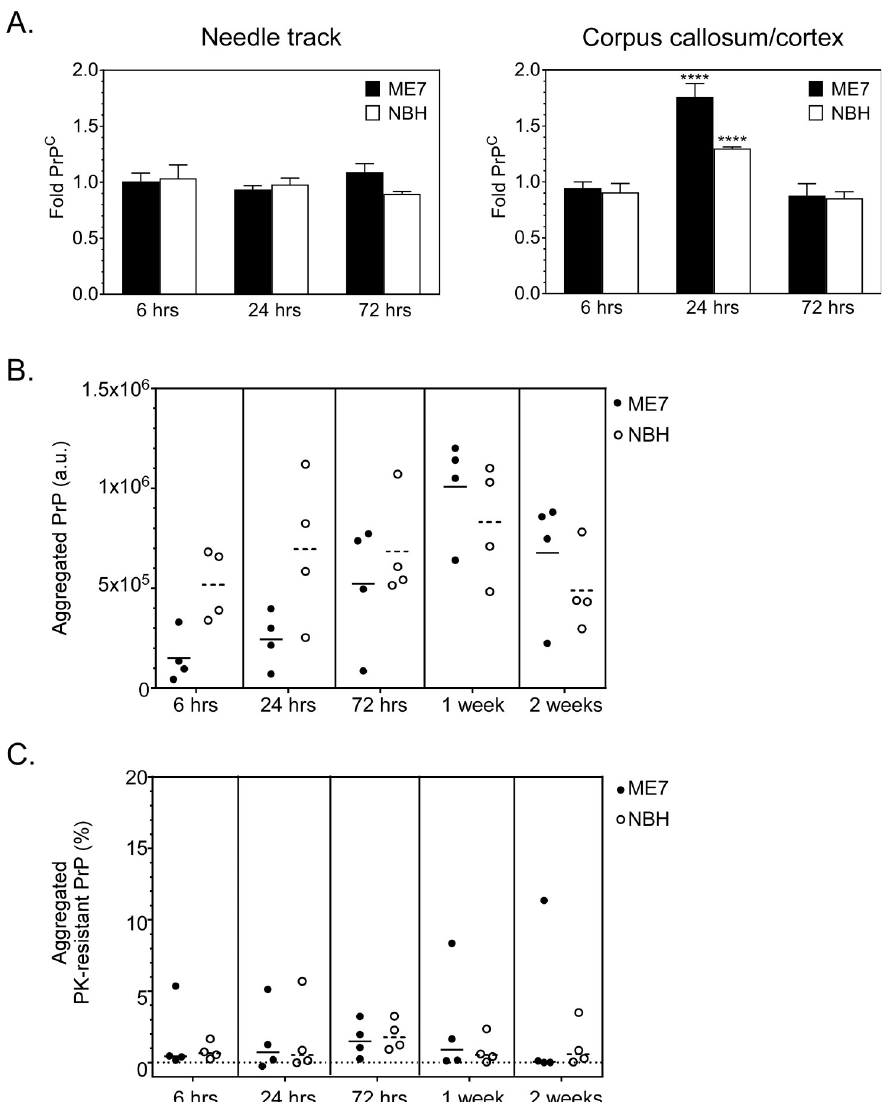
Fig 4. Increased expression and aggregation of PrP-3F4 in Tg3F4 mice inoculated with ME7 or NBH. (A) Fold increase in PrP-3F4 from the needle track and adjacent tissue (left panel) or corpus callosum and adjacent cortical tissue (right panel) in mice infected with ME7 prions (ME7, black bars) or normal mouse brain homogenate (NBH, white bars). The relative level of PrP-3F4 is expressed as a fold difference when compared to age-matched, uninoculated Tg3F4 mice as described in the Materials and Methods. Four mice were analyzed for each timepoint. Significant differences between control uninoculated mice and inoculated mice were calculated using the 1-way Anova multiple comparisons test. ���� p = 0.003. (B) Quantitation of total aggregated PrP-3F4 PTA-precipitated from the brains of Tg3F4 mice inoculated with ME7 prions (closed circles) or NBH (open symbols). (C) Quantitation of aggregated, protease-resistant PrP-3F4 PTA-precipitated from the brains of Tg3F4 mice inoculated with ME7 prions (closed circles) or NBH (open circles). The percentage of protease-resistant PrP-3F4 was calculated as described in the Materials and methods. Examples of gels used to calculate protease-resistant PrP-3F4 for 3 different timepoints are shown in S5 Fig. For panels B and C, the short horizontal lines indicate the mean of n = 4 ME7 samples (solid line) or n = 4 NBH samples (dashed lines). The long horizontal dotted line in Panel C indicates 0 on the y-axis. a.u. = arbitrary units.